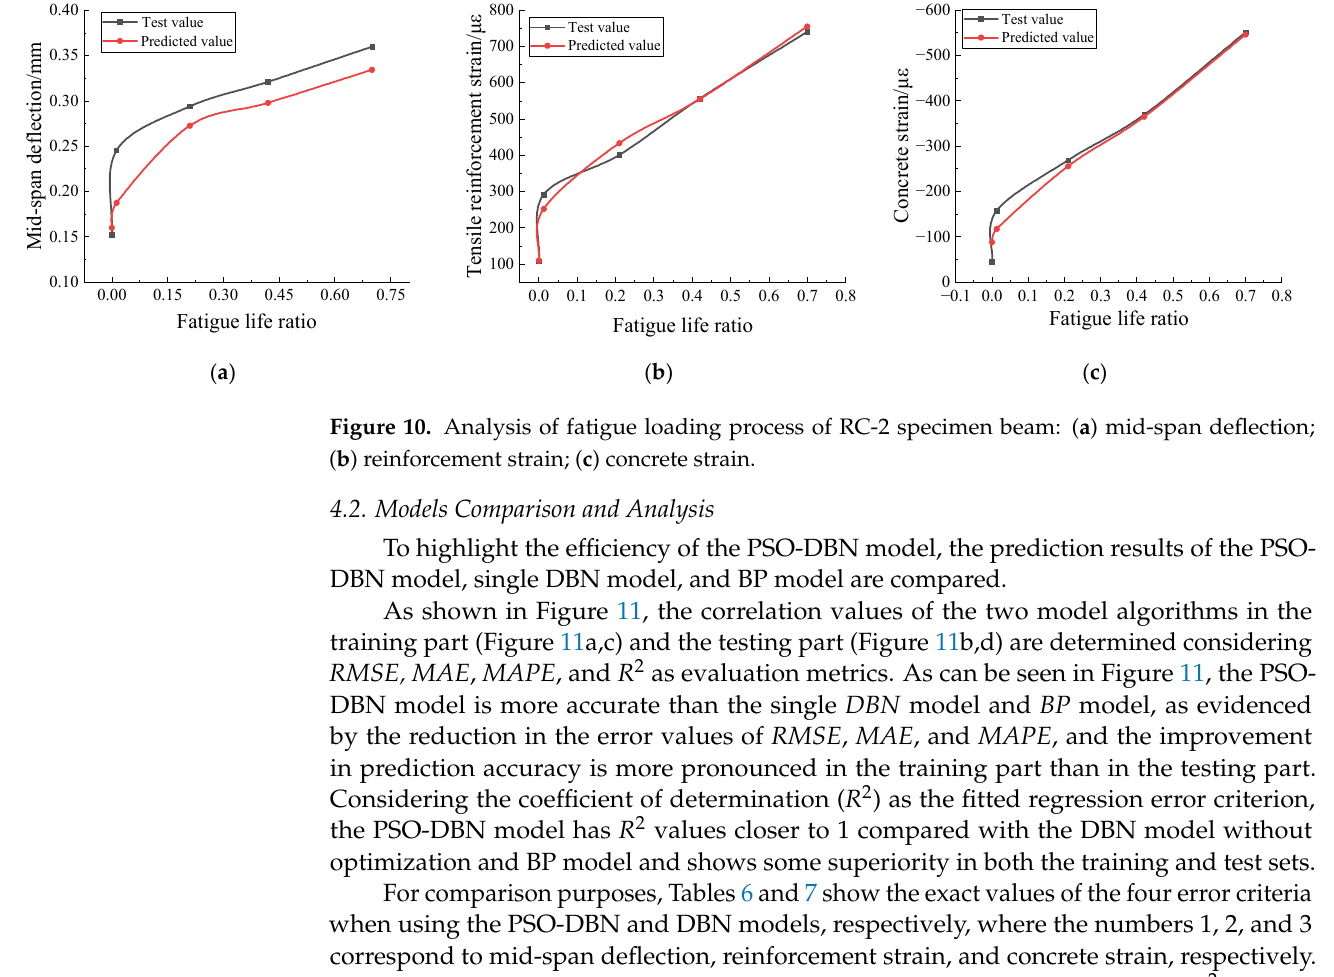
Figure 9. Correlation analysis between test and predicted values of fatigue performance of RC spec- imen beams: ( a ) mid-span deflection prediction for training data; ( b ) mid-span deflection prediction for test data; ( c ) reinforcement strain prediction for training data; ( d ) reinforcement strain prediction for test data; ( e ) concrete strain prediction for training data; and ( f ) concrete strain prediction for test data. To illustrate the accuracy of the model in this paper in predicting the fatigue perfor- mance of RC beams, the model predicts the mid-span deflection, tensile reinforcement